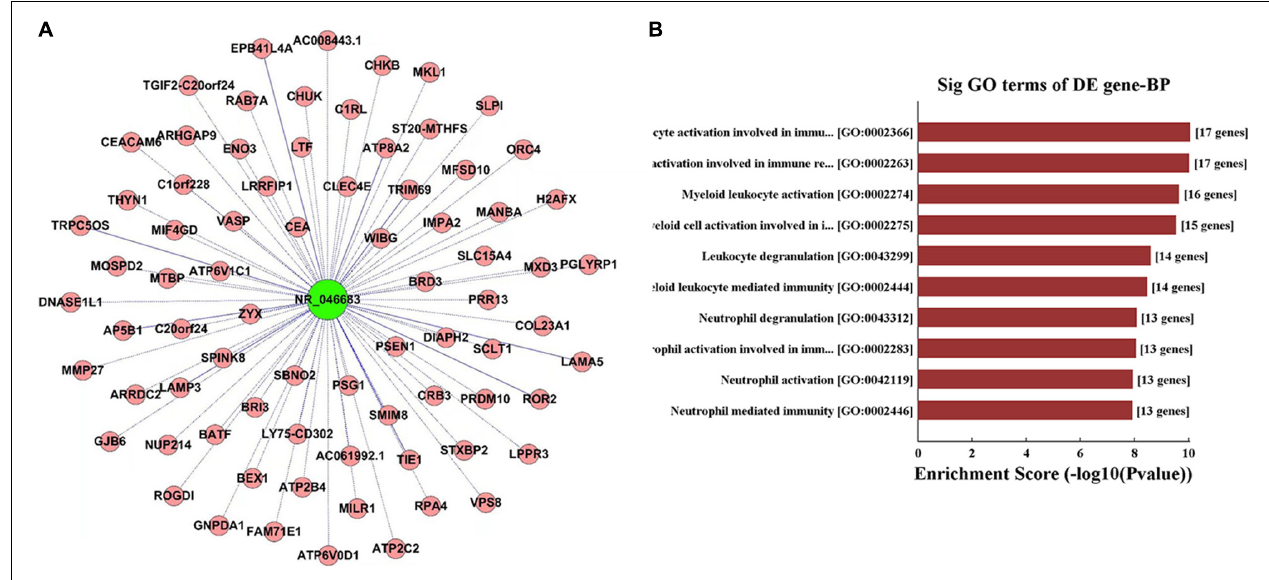
FIGURE 3 | Functional analysis of IncRNA. (A) lncRNA-mRNA co-expression network established using lncRNA NR_046683. (B) The top ten Enrichment Score value of the significant enrichment terms.